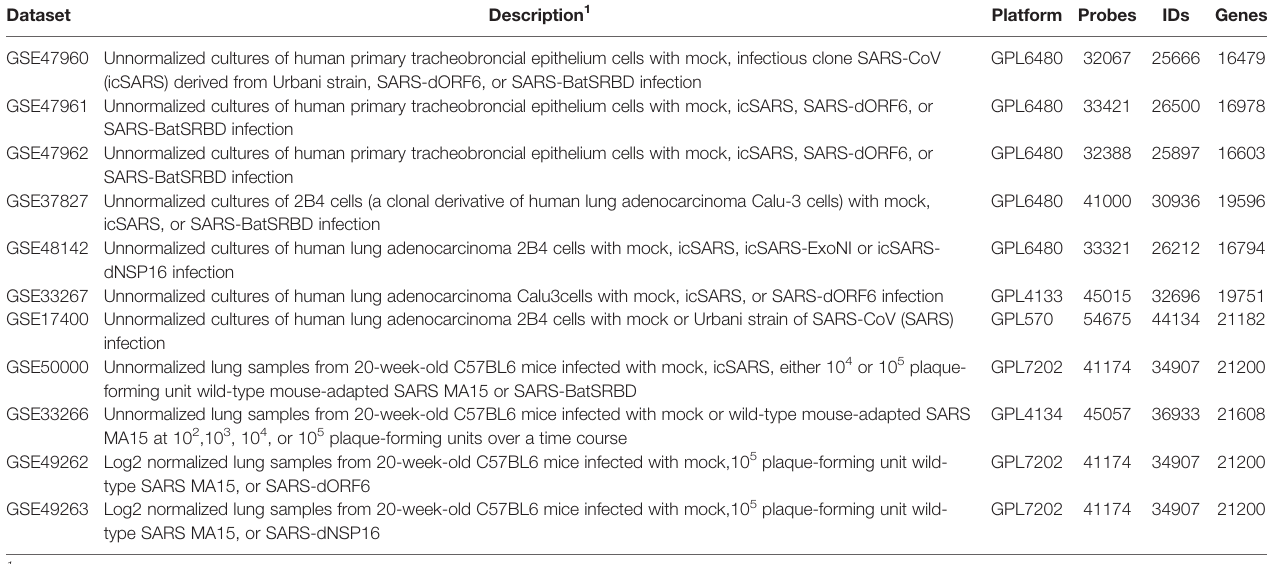
TABLE 1 | SARS-CoV Infection Datasets Utilized for this